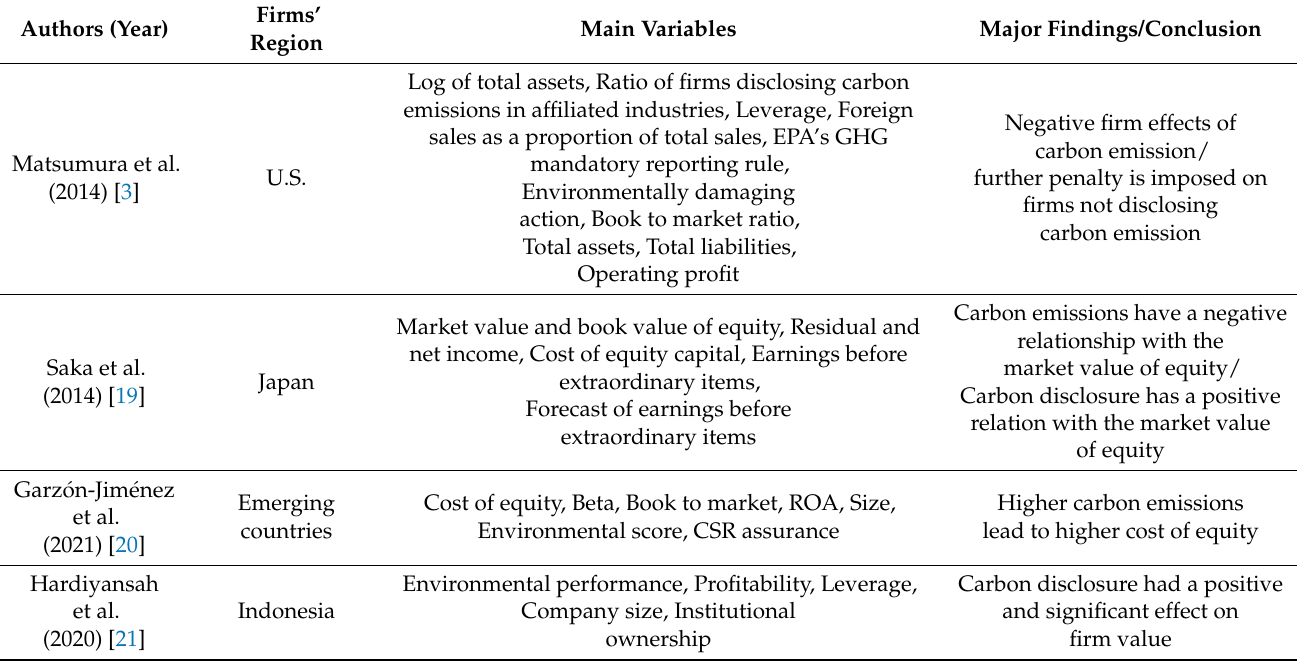
Table 1. Previous research on the relationship between carbon emission, disclosures, and firm